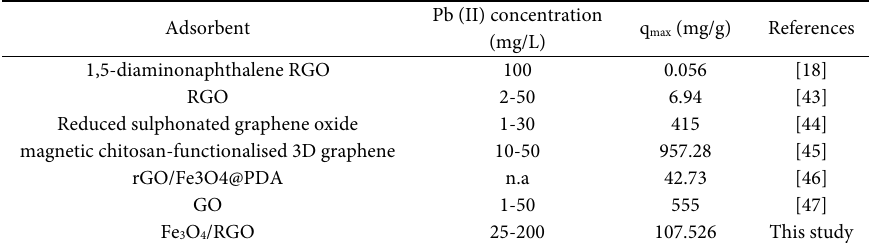
Table 3. Comparison of the maximum adsorption capacities of Pb (II) ions onto various adsorbents.